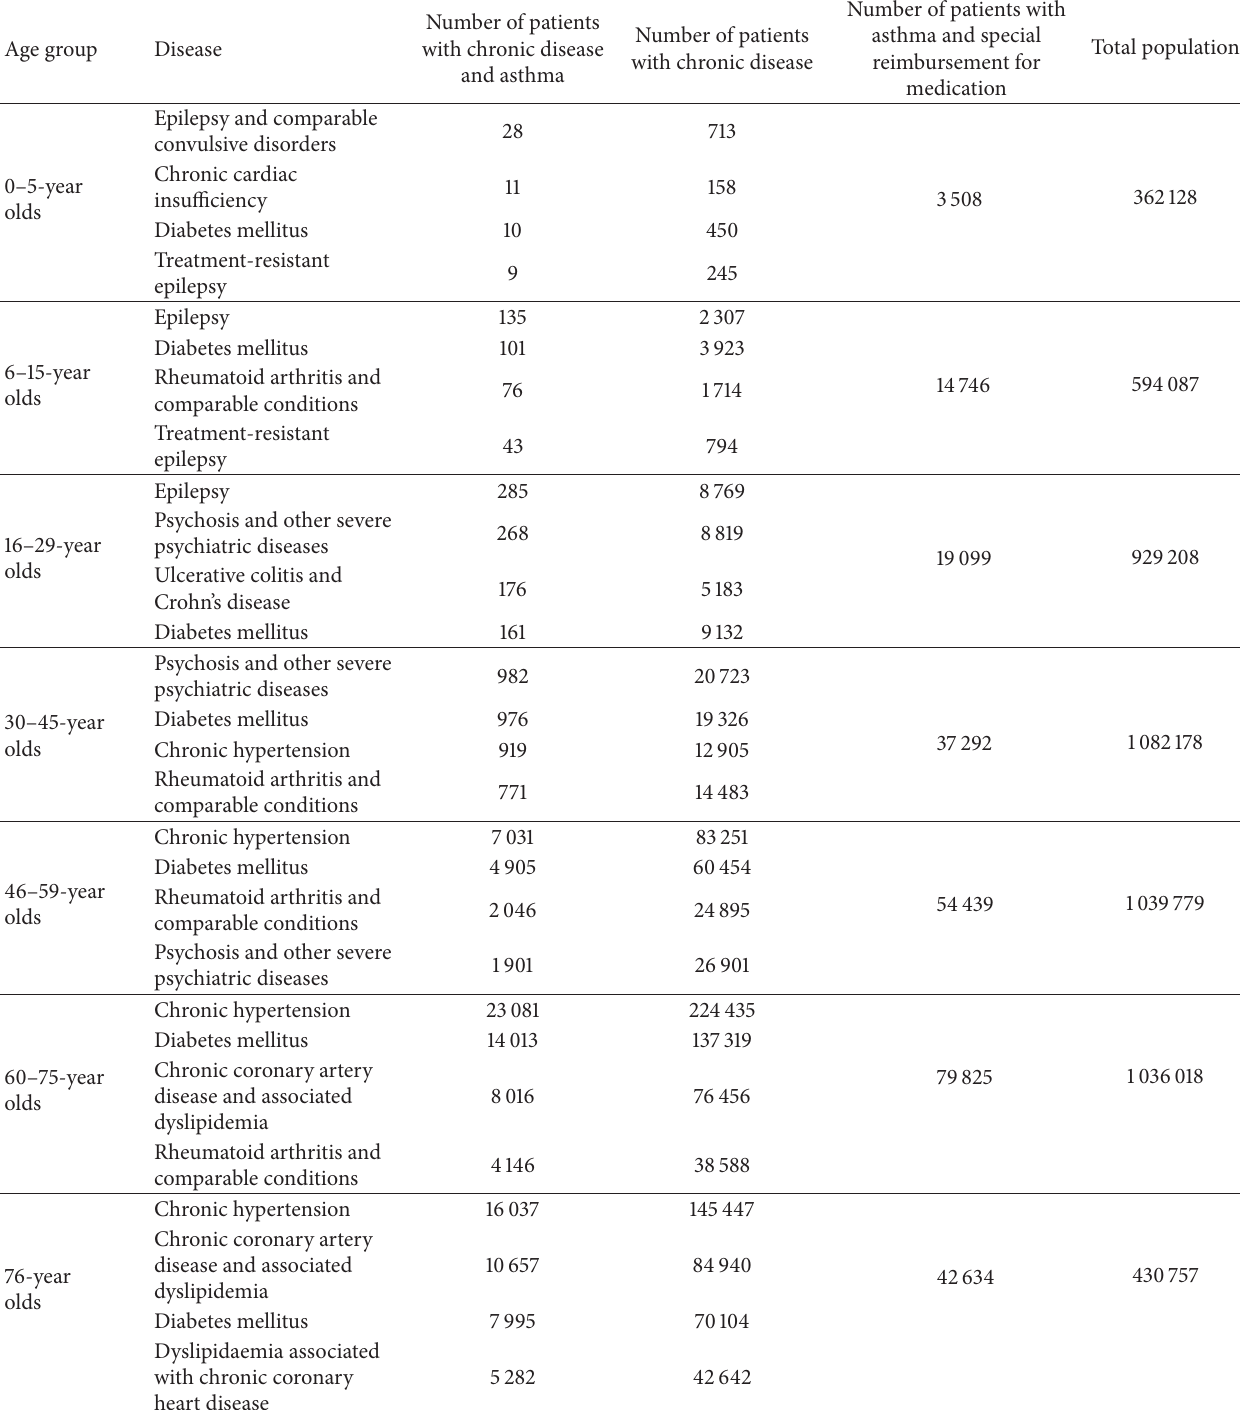
Table 1: The four most common comorbidities in asthma patients in different age groups according to Special Reimbursement Register. Total numbers of asthmatic patients, asthmatic patients with the disease, and all the patients with the diseases in year